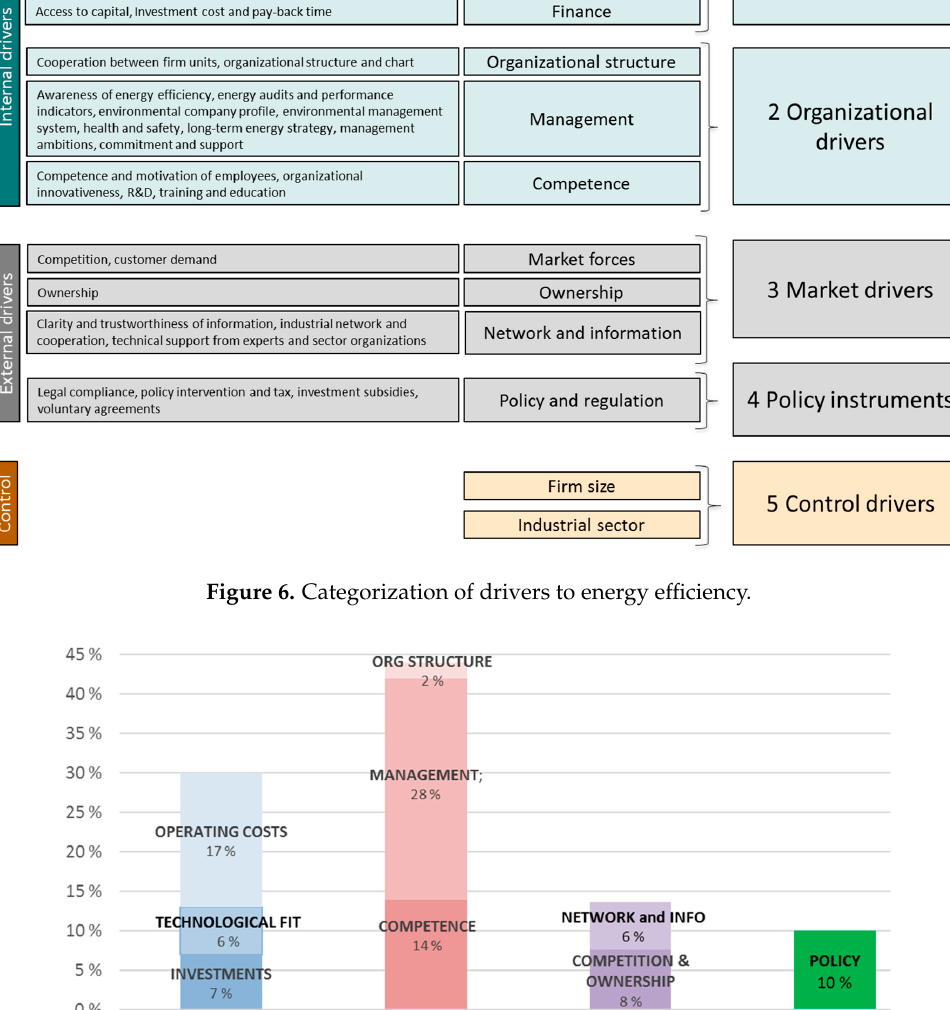
Figure 7. Presentation of the distribution of the most important drivers by category.